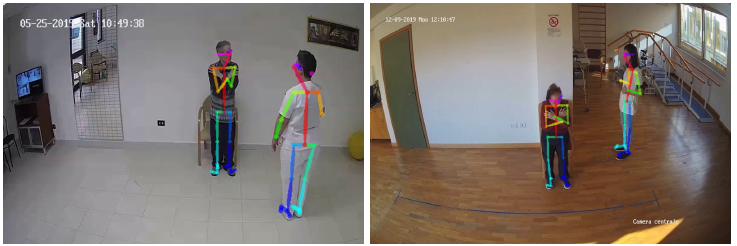
Figure 3. Sample frames of the videos acquired in the two different nursing homes.